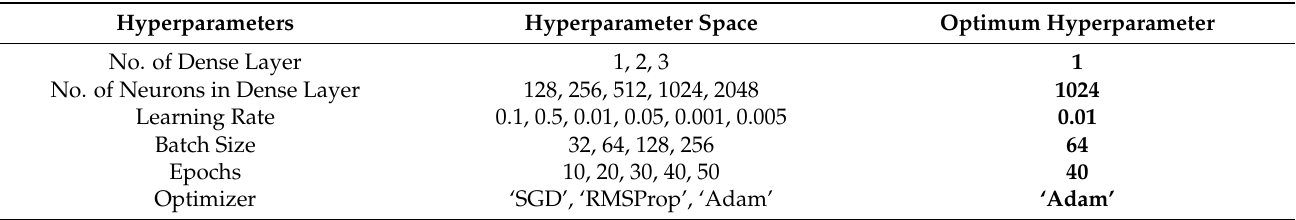
Table 6. Hyperparameter selection from the hyperparameter space for the